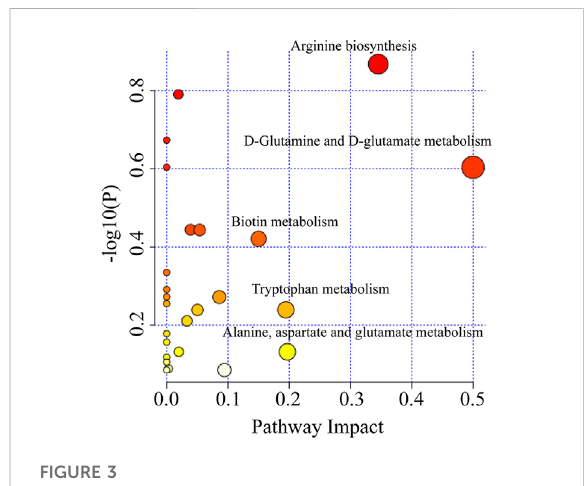
FIGURE 3 Enrichment of pathway analysis with